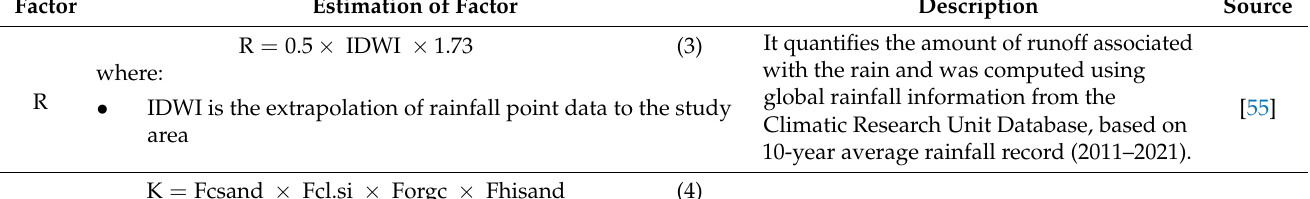
Table 2. Description of each factor used in RUSLE equation for estimating soil loss. Factor Estimation of Factor with the rain and was computed